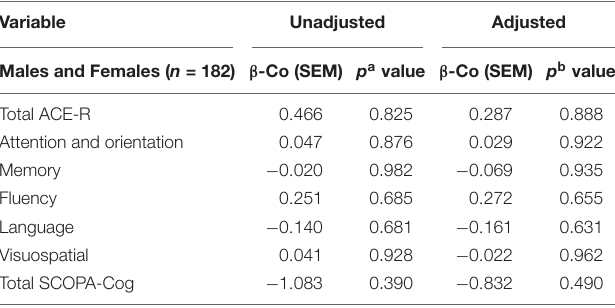
assessment, age of onset and disease duration. ACE-R, Addenbrooke’s Cognitive Examination – Revised; SCOPA-Cog, Scales for Outcomes in Parkinson’s Disease Cognition.